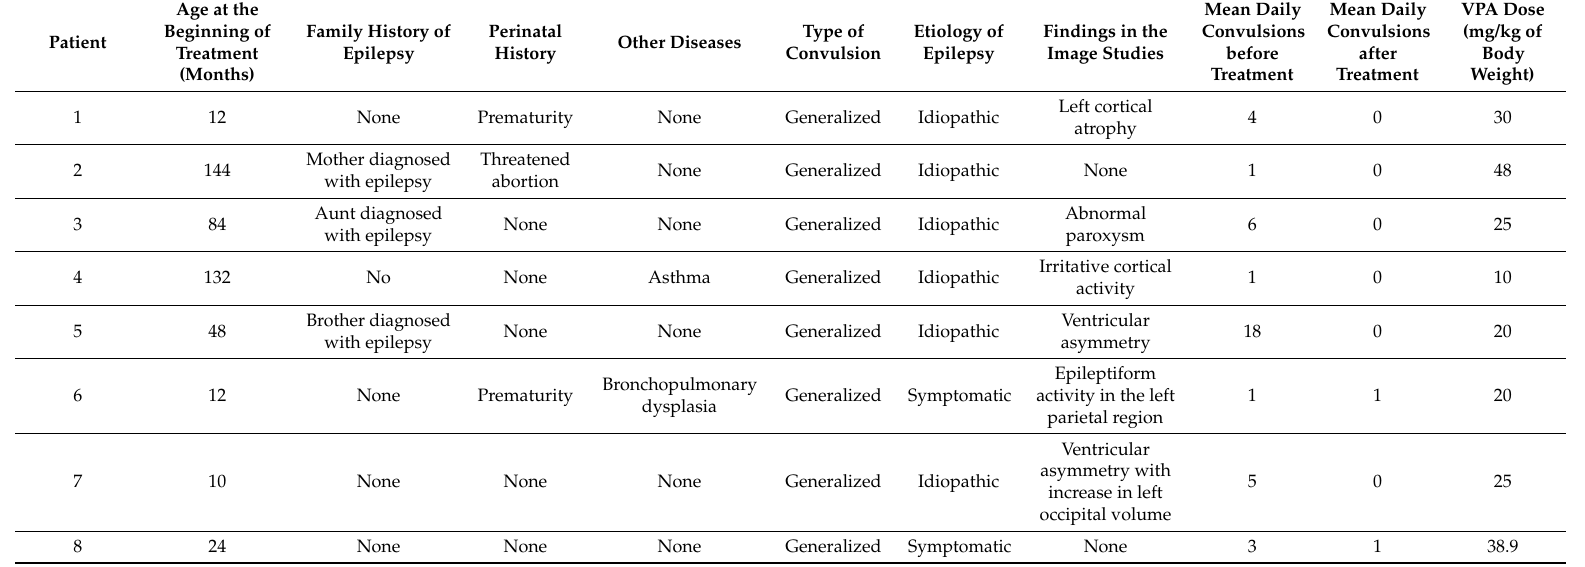
Table 1. Clinicopathological characterization of the patients included in the microarray study. VPA: Valproic